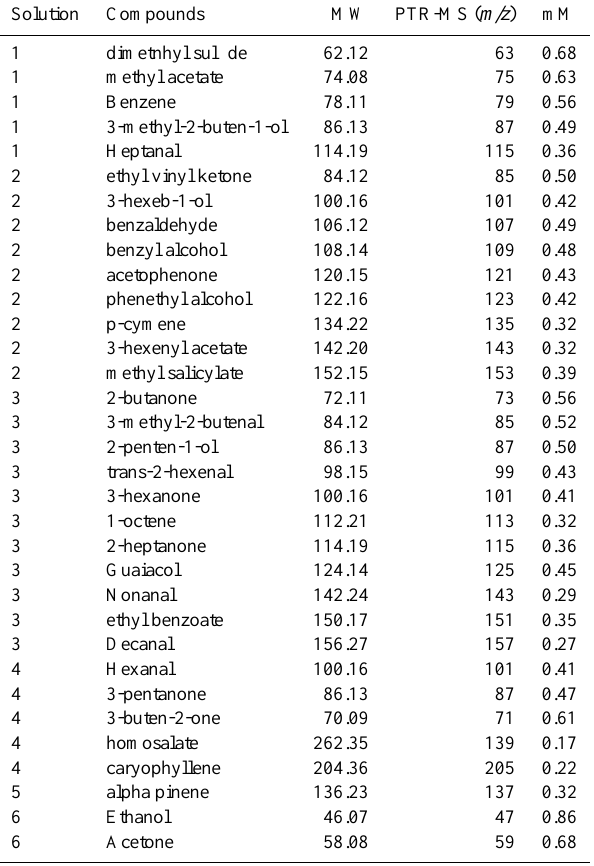
Table 1. Six cyclohexane solutions used to calibrate a PTR-MS using the DSI technique. Solutions 5–6 ( α -pinene, ethanol, and acetone) were also prepared in both cyclohexane and methanol for PTR-MS and GC-MS